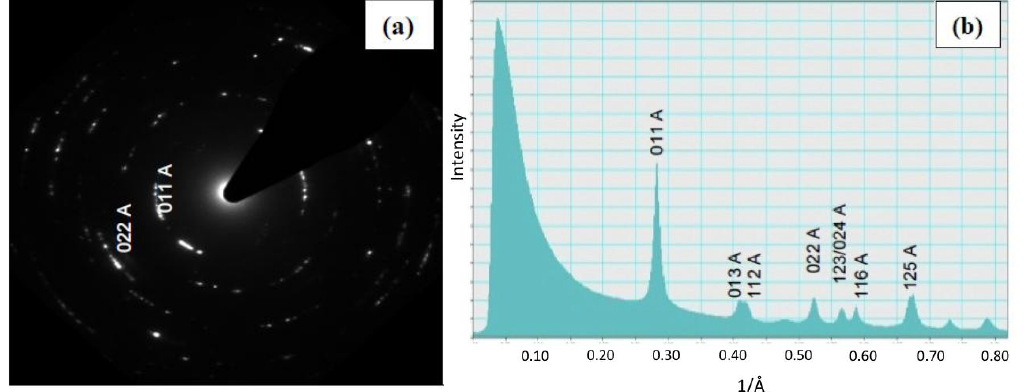
NTs away from substrate and thin bulk TiO 2